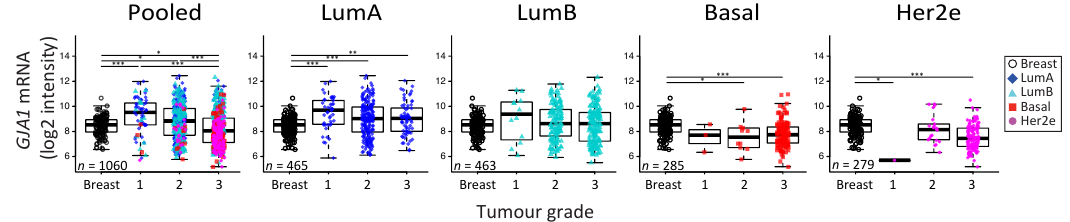
Figure 6. GJA1 mRNA level is downregulated with grade in clinical samples only in pooled tumors but not in individual subtypes. GJA1 mRNA level for each tumor grade in the Curtis Discovery dataset, either in pooled breast tumors or stratified by intrinsic subtype. In the legend, “Breast” indicates adjacent normal breast tissue. p value: * <0.05; ** <0.01; *** <0.001.